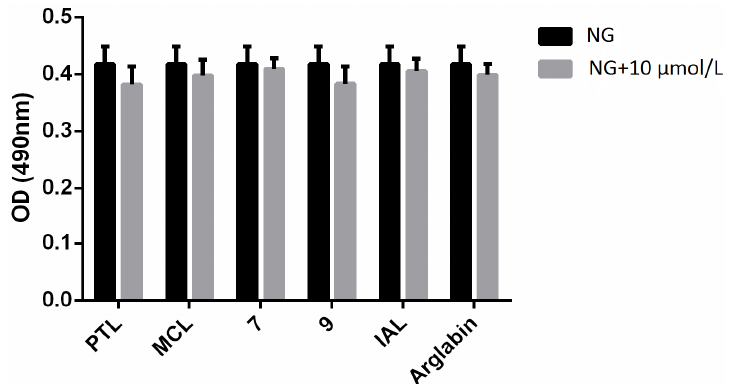
Figure 8. Effect of sesquiterpene lactones on viability of MCs at a concentration of 10 μ M. NG: normal glucose for 24